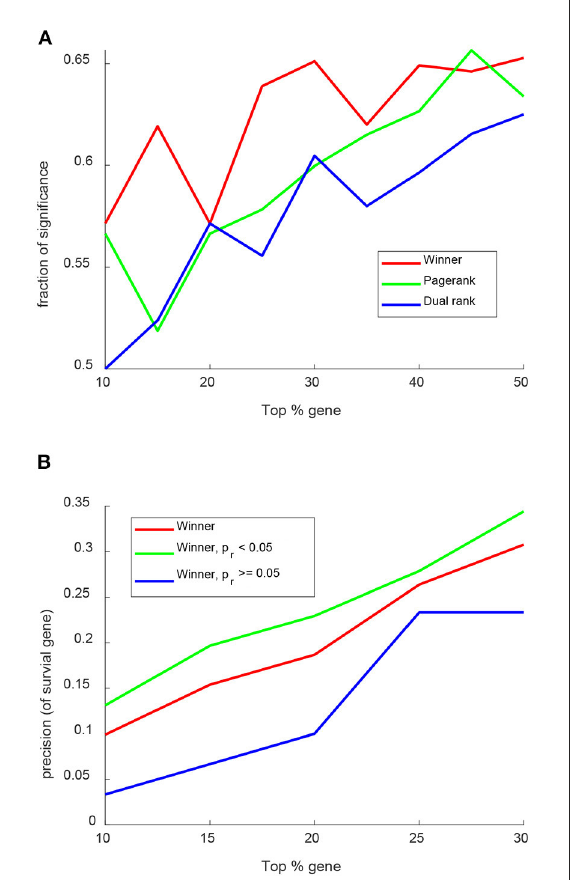
FIGURE4 WINNER gene prioritization more accurately identifies the relationship between breast-cancer genes and patient survival. Genes in the KEGG breast-cancer pathway were ranked via WINNER, PageRank, and Dual Rank, and the significance of each gene’s relationship to patient survival was determined with an online Kaplan-Meier plotting tool. (A) The proportion of genes that were significantly ( p < 0.05) related to breast-cancer survival was determined for the top 0-50% of ranked genes. (B) The precision of the WINNER ranking of genes for breast-cancer survival (Bland and Altman, 1998) was compared for the top 0–30% of ranked genes with p r < 0.05 and p r 0.05. ≥